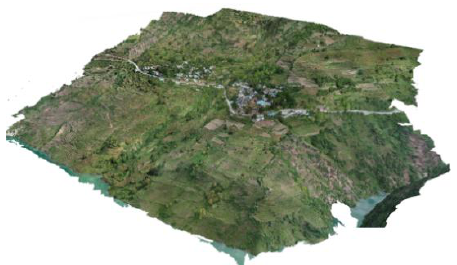
Figure 6 . Refined 3D scene model overview.